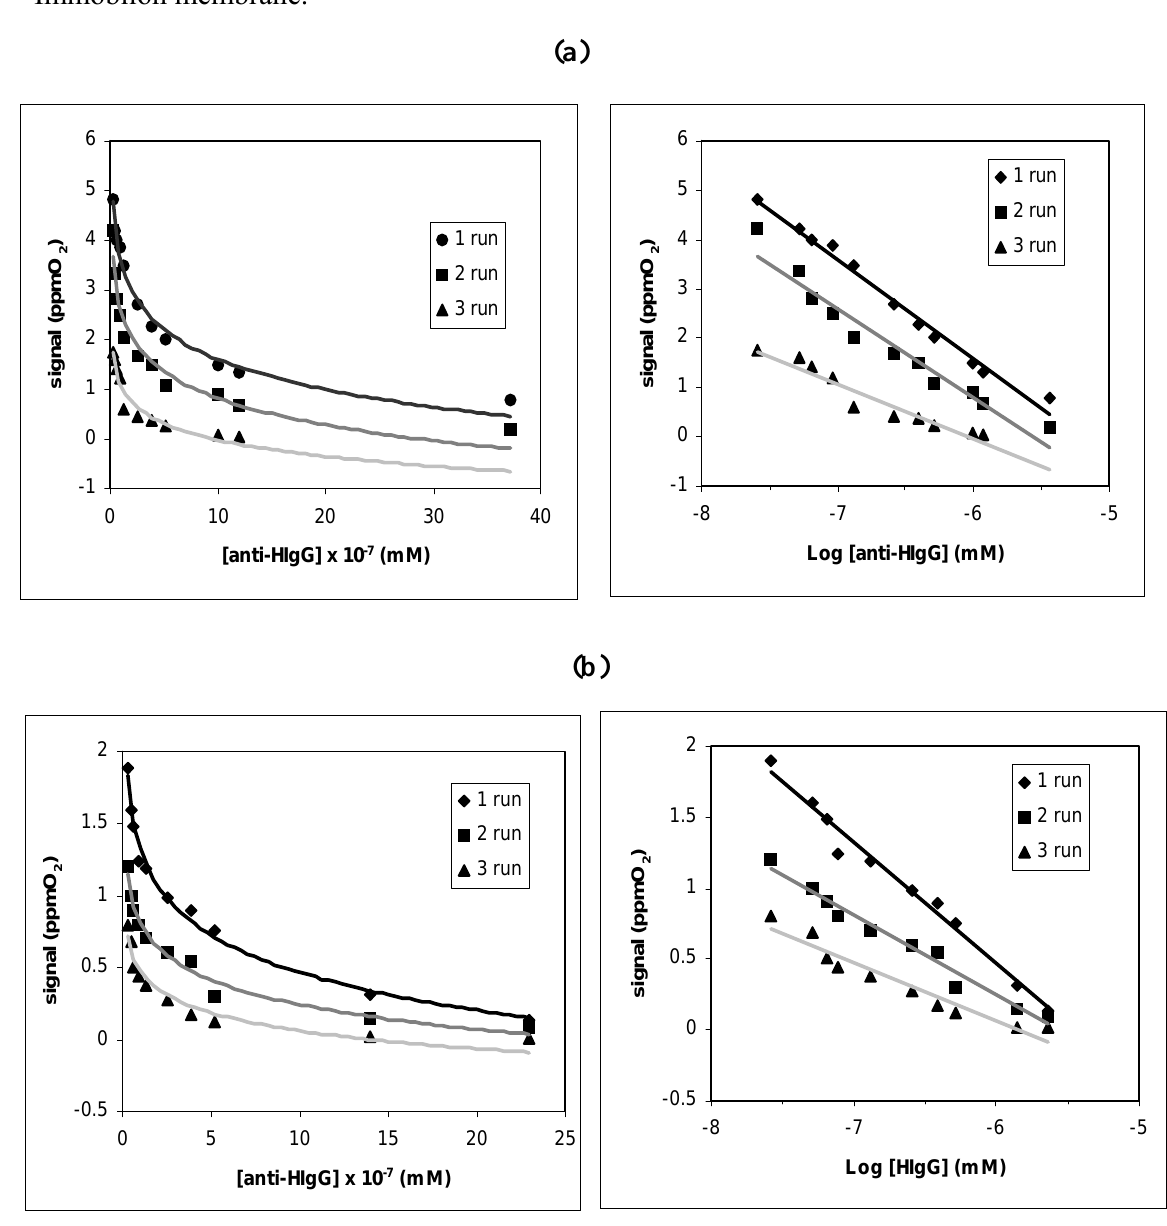
2.5 M, using (a) Pall-Biodyne membrane, (b) 2